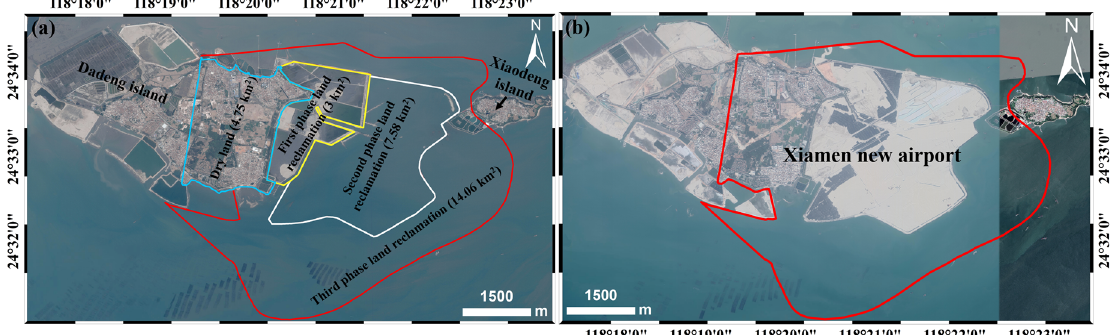
Figure 2. Landsat-8 remote-sensing images of the study area acquired on ( a ) 26 March 2014 and ( b ) 13 March 2018. The blue line represents the dry land area (4.75 km 2 ) of the airport, the yellow line indicates the first phase (3 km 2 ), the white line indicates the second phase (7.58 km 2 ), and the red line indicates the third phase (14.06 km 2 ) of marine reclamation land.